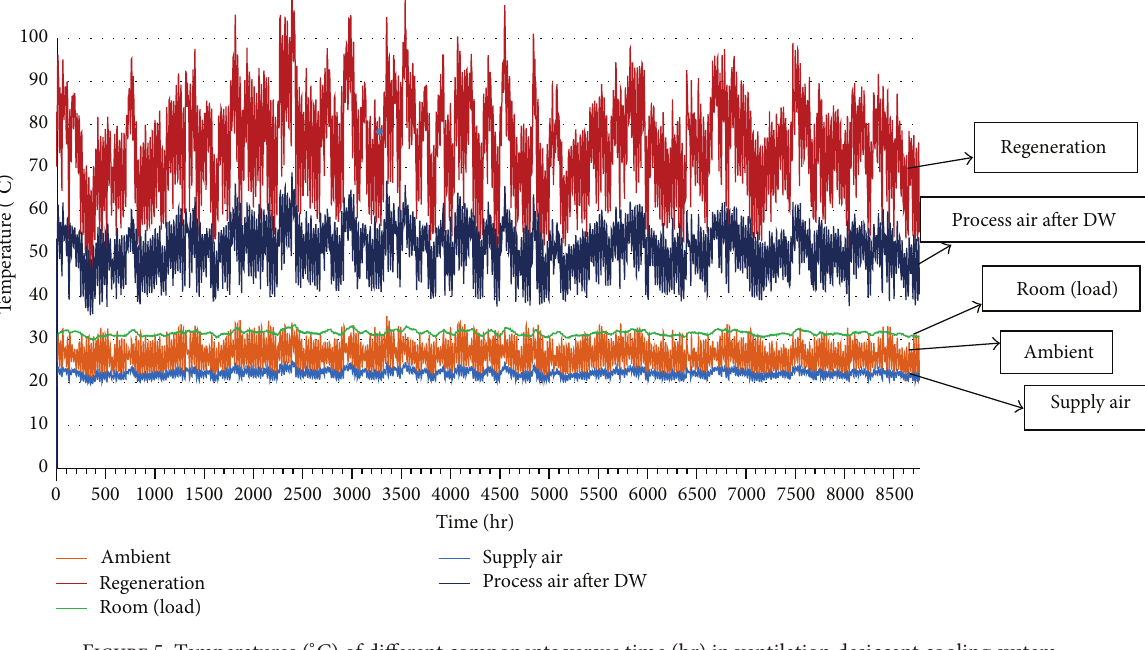
Figure 5: Temperatures ( ∘ C) of different components versus time (hr) in ventilation desiccant cooling system.